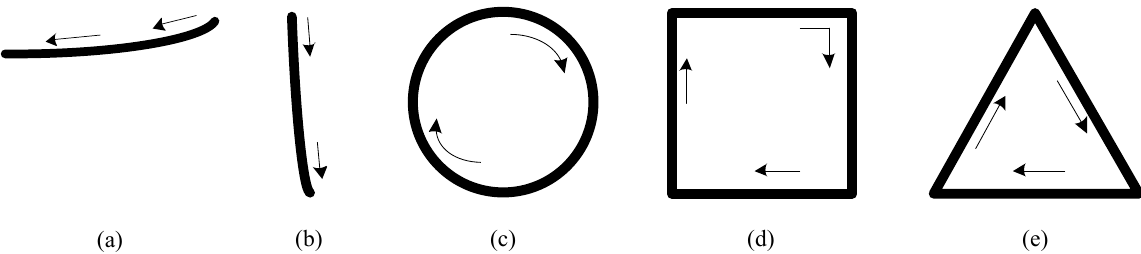
Figure 2. The direction of hand movement for each gesture: (a) sweeping right to left, (b) sweeping top to bottom, (c) circle motion, (d) square motion, (e) triangle